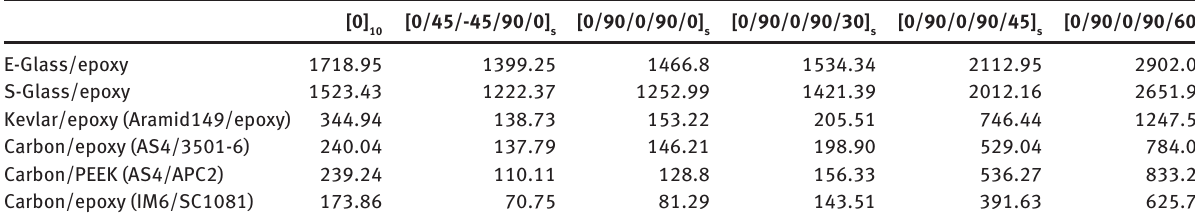
Table 7 Comparison of the critical energy release rate G (N/m) obtained from meshfree methods (nodes: 11 × 19).